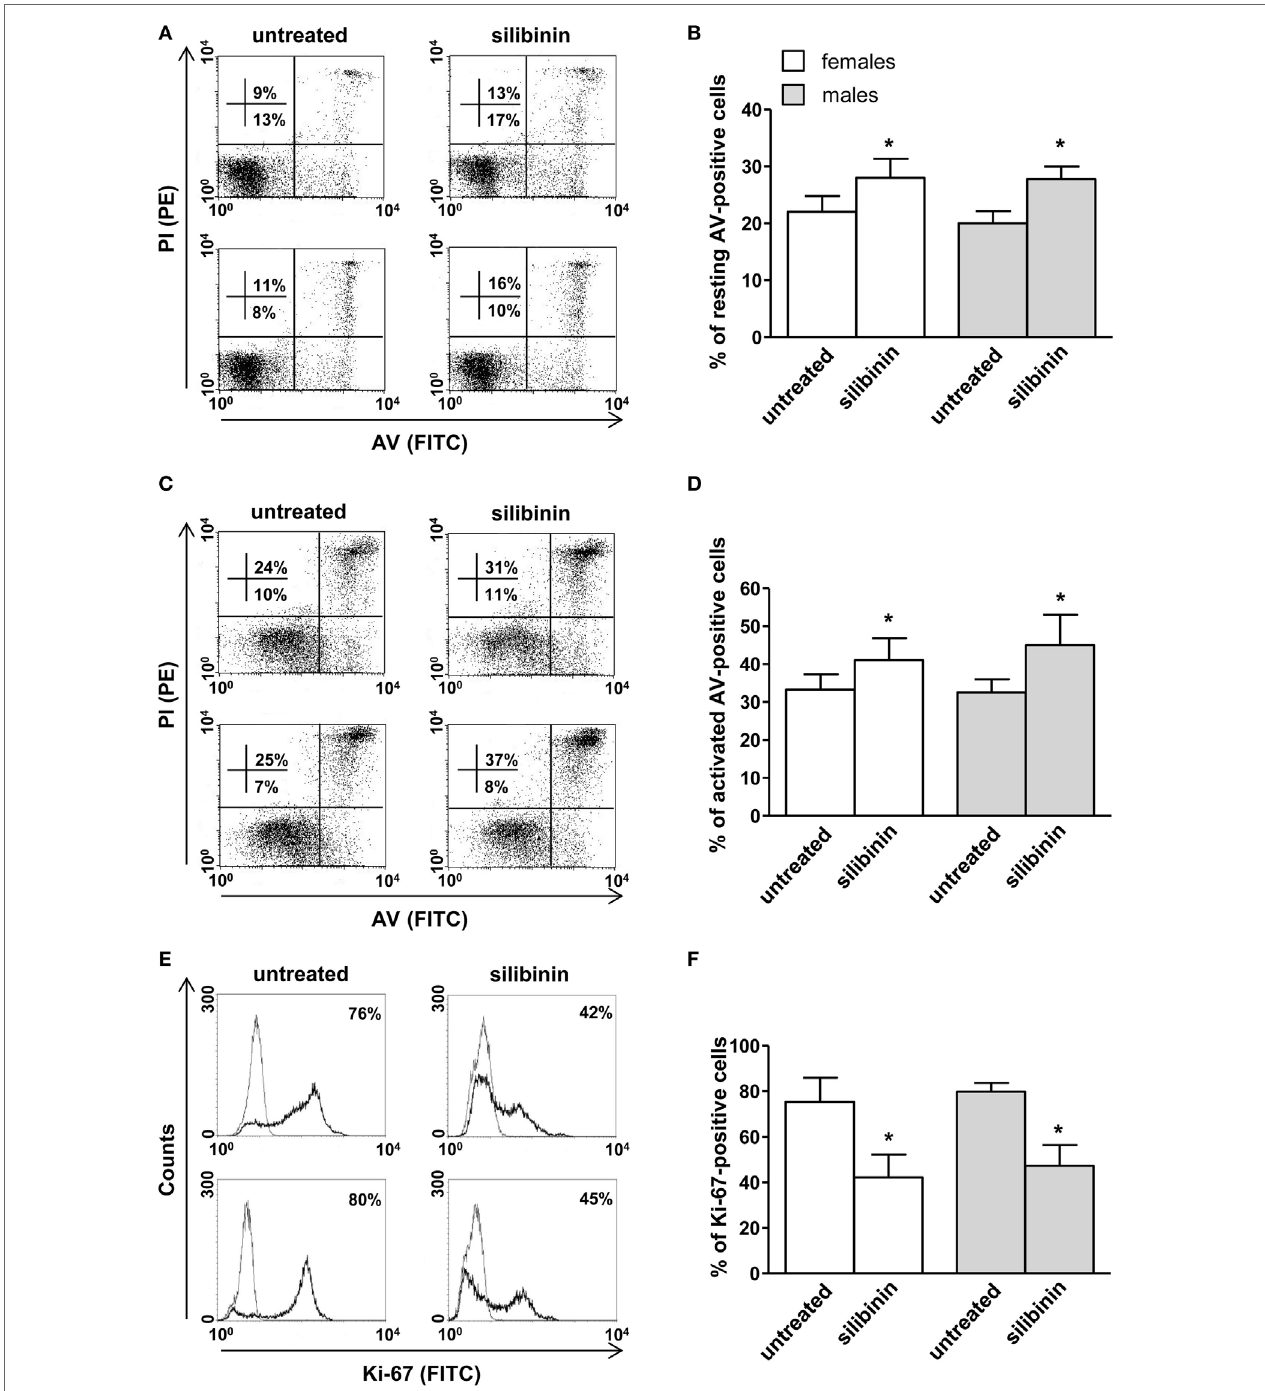
FigUre 5 | Silibinin-dependent effects on apoptosis and proliferation levels of peripheral blood T lymphocytes from patients with active rheumatoid arthritis (RA). All experiments were performed in 10 female and 4 male RA patients. (a–D) Apoptosis assay involving dual staining with annexin V (AV) and propidium iodide (PI) was carried out using flow cytometry in resting T cells treated or not with silibinin for 48 h (a,b) and in T cells activated by anti-CD3 monoclonal antibody (mAb) for 72 h and treated or not with silibinin for the last 48 h of culture (c,D) . Results from representative female (upper panels) and male (lower panels) RA patients are shown (a,c) . Numbers reported represent the percentages of AV positive/PI negative (early apoptotic, bottom right quadrant) and AV positive/PI positive (late apoptotic or necrotic cells, top right quadrant). Data referred to both AV positive/PI negative and AV positive/PI positive cells are also reported as mean ± SD (b,D) . (e,F) Cell proliferation was evaluated by flow cytometry measuring Ki-67 nuclear antigen expression in T lymphocytes after activation with anti-CD3 mAb for 72 h and treatment with silibinin for the last 48 h of culture. Results from representative female (upper panels) and male (lower panels) RA patients are shown (e) . Data are also reported as mean ± SD (F) . * P < 0.05 versus untreated